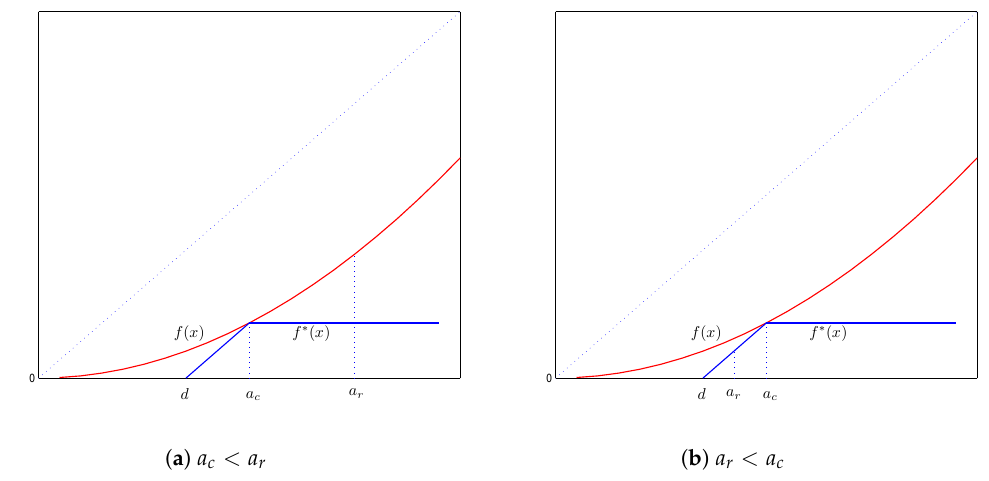
Figure 3. Optimal ceded functions in C 1 : Case